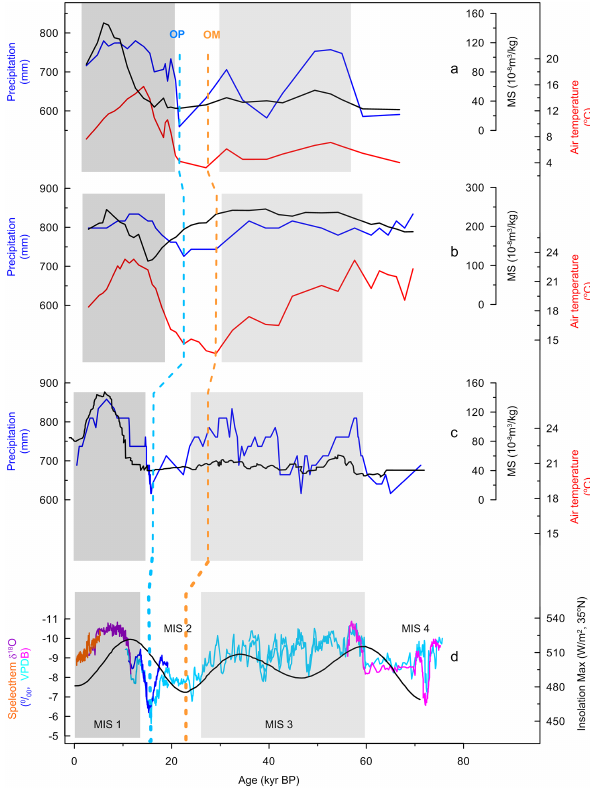
Figure 7. (a) Calibration plot of CBT vs. local MAP of surface CLP soils collected in this study. (b) MAP vs. residual MAP (meteoro- logical MAP – estimated MAP using the surface soil calibration in the CLP). Grey shade marks the data within the RMSE (50mm).